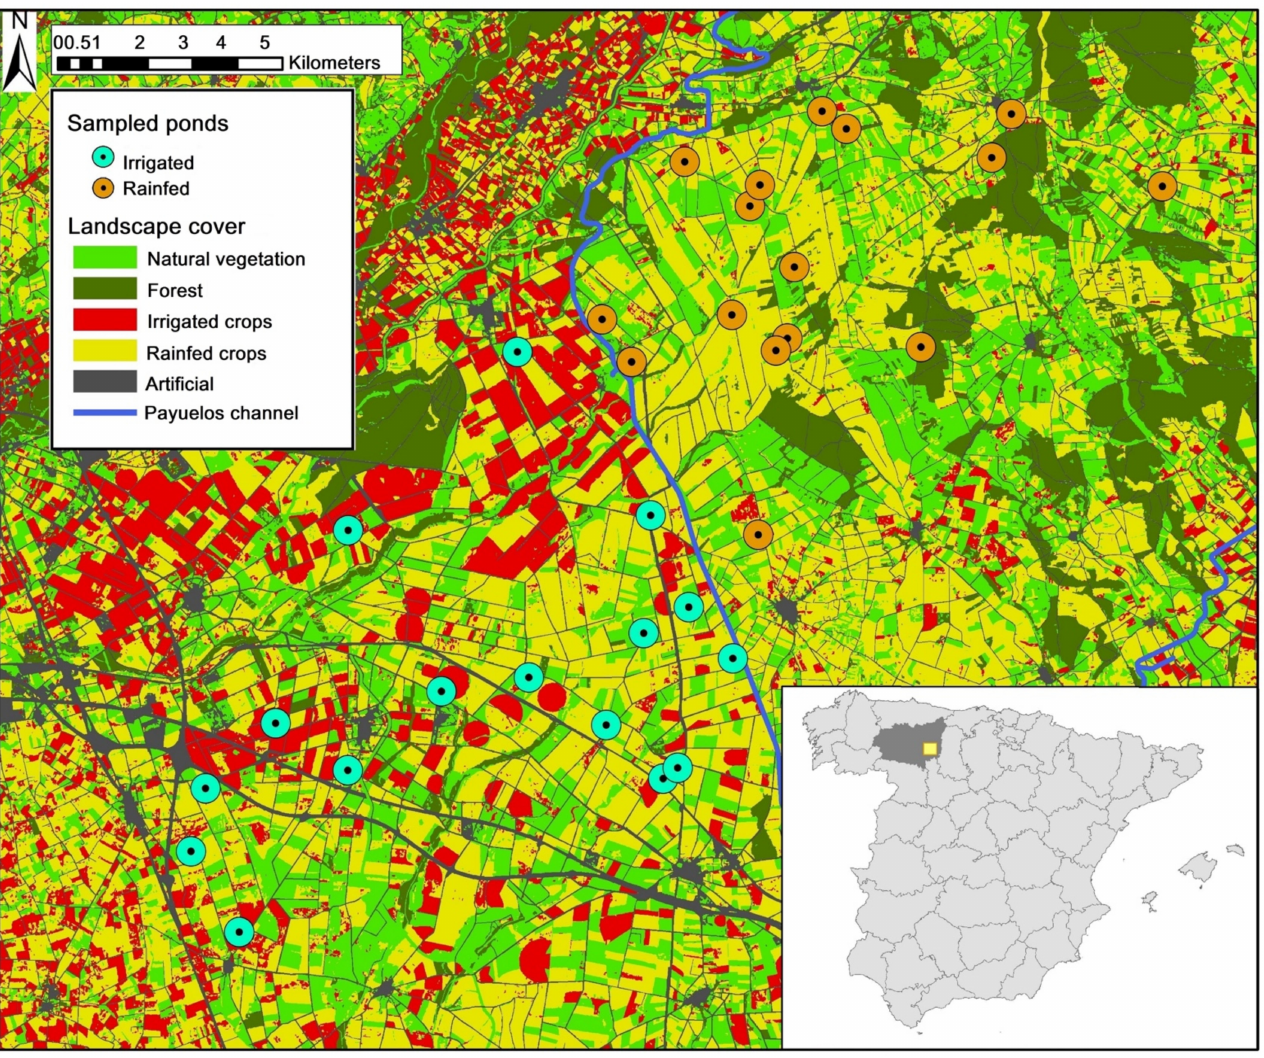
Figure 1. Map of the study area showing its location in Le ó n Province (Spain, inset), landscape cover types and sampled ponds in each agricultural management group. The blue line represents Payuelos Channel. “Natural vegetation” includes scrub, grassland and bare soil; “Artificial” includes roads and urban